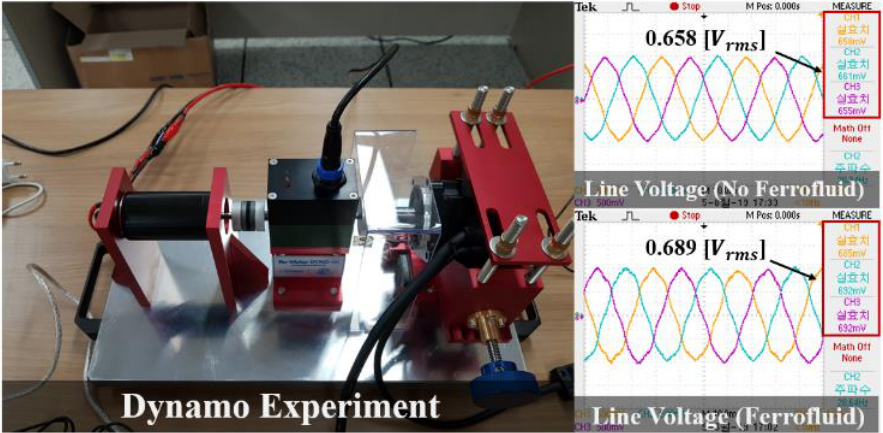
Figure 22. Dynamo experiment and results (572 rpm).